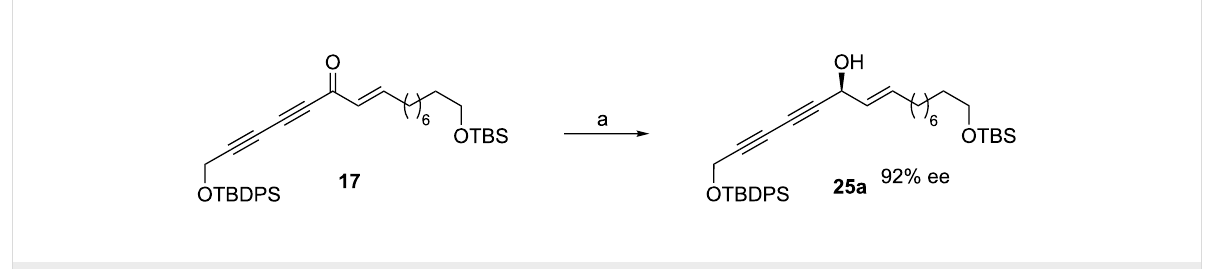
After securing the absolute configuration at C6 in compound